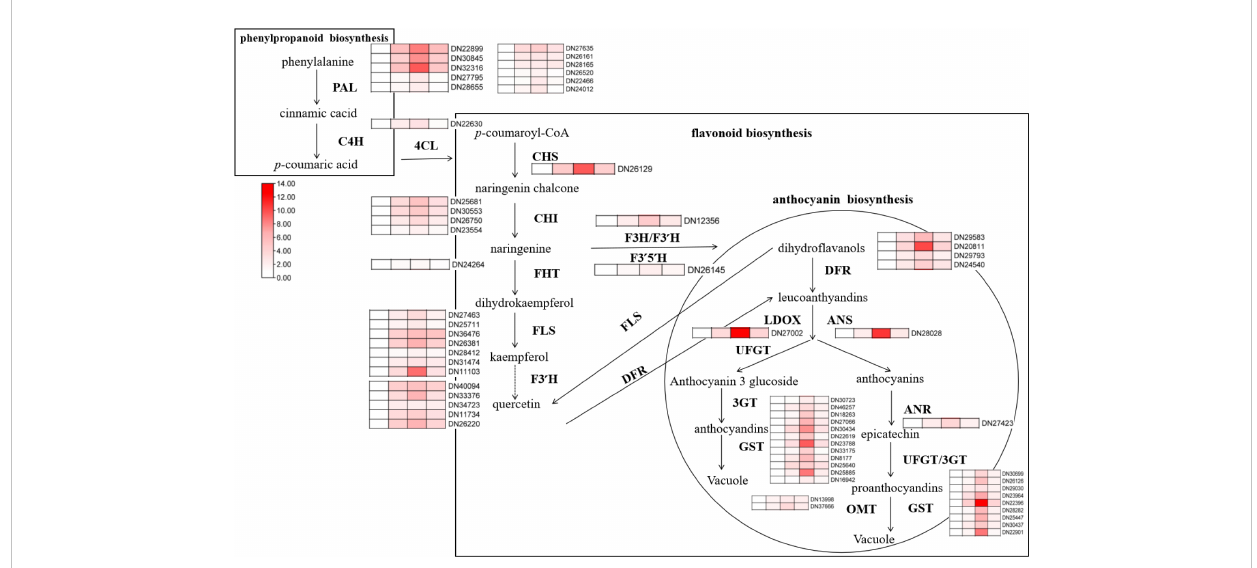
FIGURE 8 RT-PCR analysis of the effects of exogenous ABA and SNP on the expression of related genes in the synthesis pathways of phenylpropane, fl avonoids and anthocyanins under alkaline stress. 40-day-old seedlings were treated with different treatments (100 mM alkali, 100 mM alkali +15 m m ABA, 100 mM alkali +50 m m SNP) for 12 days (AS : NaHCO3: Na 2 CO 3 = 9:1, pH=9.5). Plants grew in Hoagland solution served as controls (CK). The detected genes include: NtPAL (DN22899/DN30845/DN32316/DN27795/DN28855), NtC4H